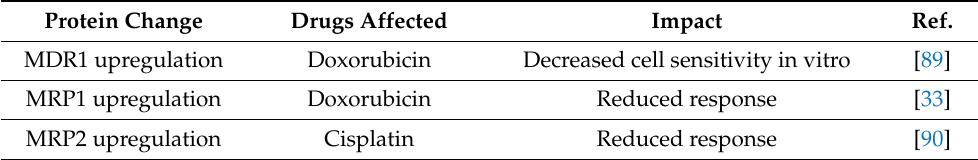
Table 4. Role of ABC proteins in chemoresistance of hepatoblastoma (HB). Protein Change Drugs Affected Impact Ref. MDR1 upregulation Doxorubicin Decreased cell sensitivity in vitro [89] MRP1 upregulation Doxorubicin Reduced response [33] MRP2 upregulation Cisplatin Reduced response